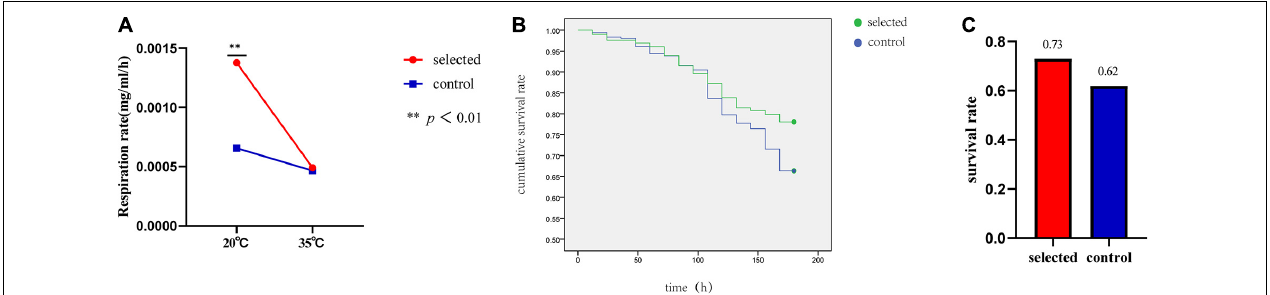
FIGURE 4 | The respiration rate of selected group and control group at 20 and 35 ◦ C (A) . Summer survival in the selected and control groups (B) . The survival rates of selected group and control group after heat shock at 42 ◦ C for 1 h (C) .